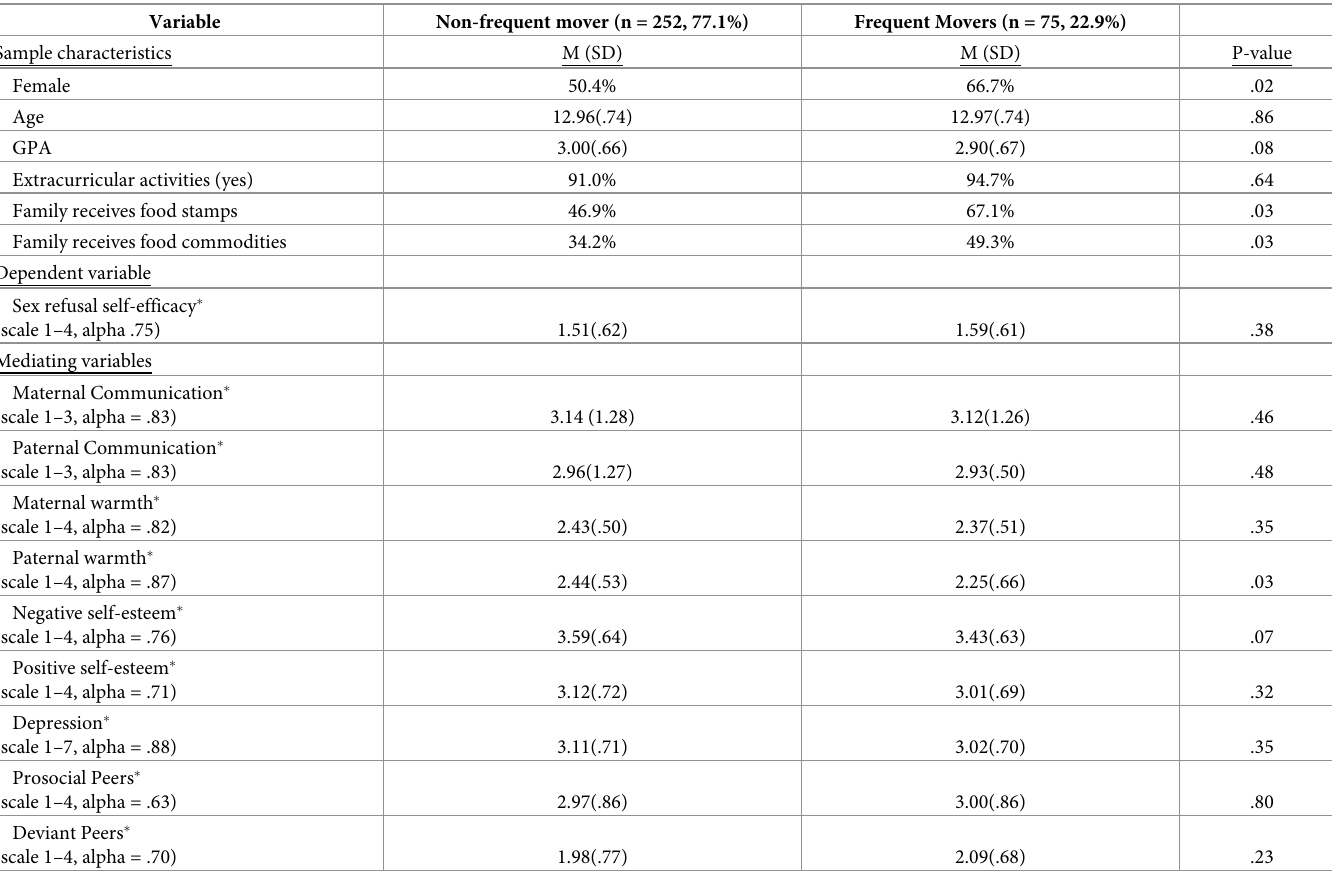
Table 1. Descriptive statistics of the Wiconi sample characteristics and study variables by residential mobility